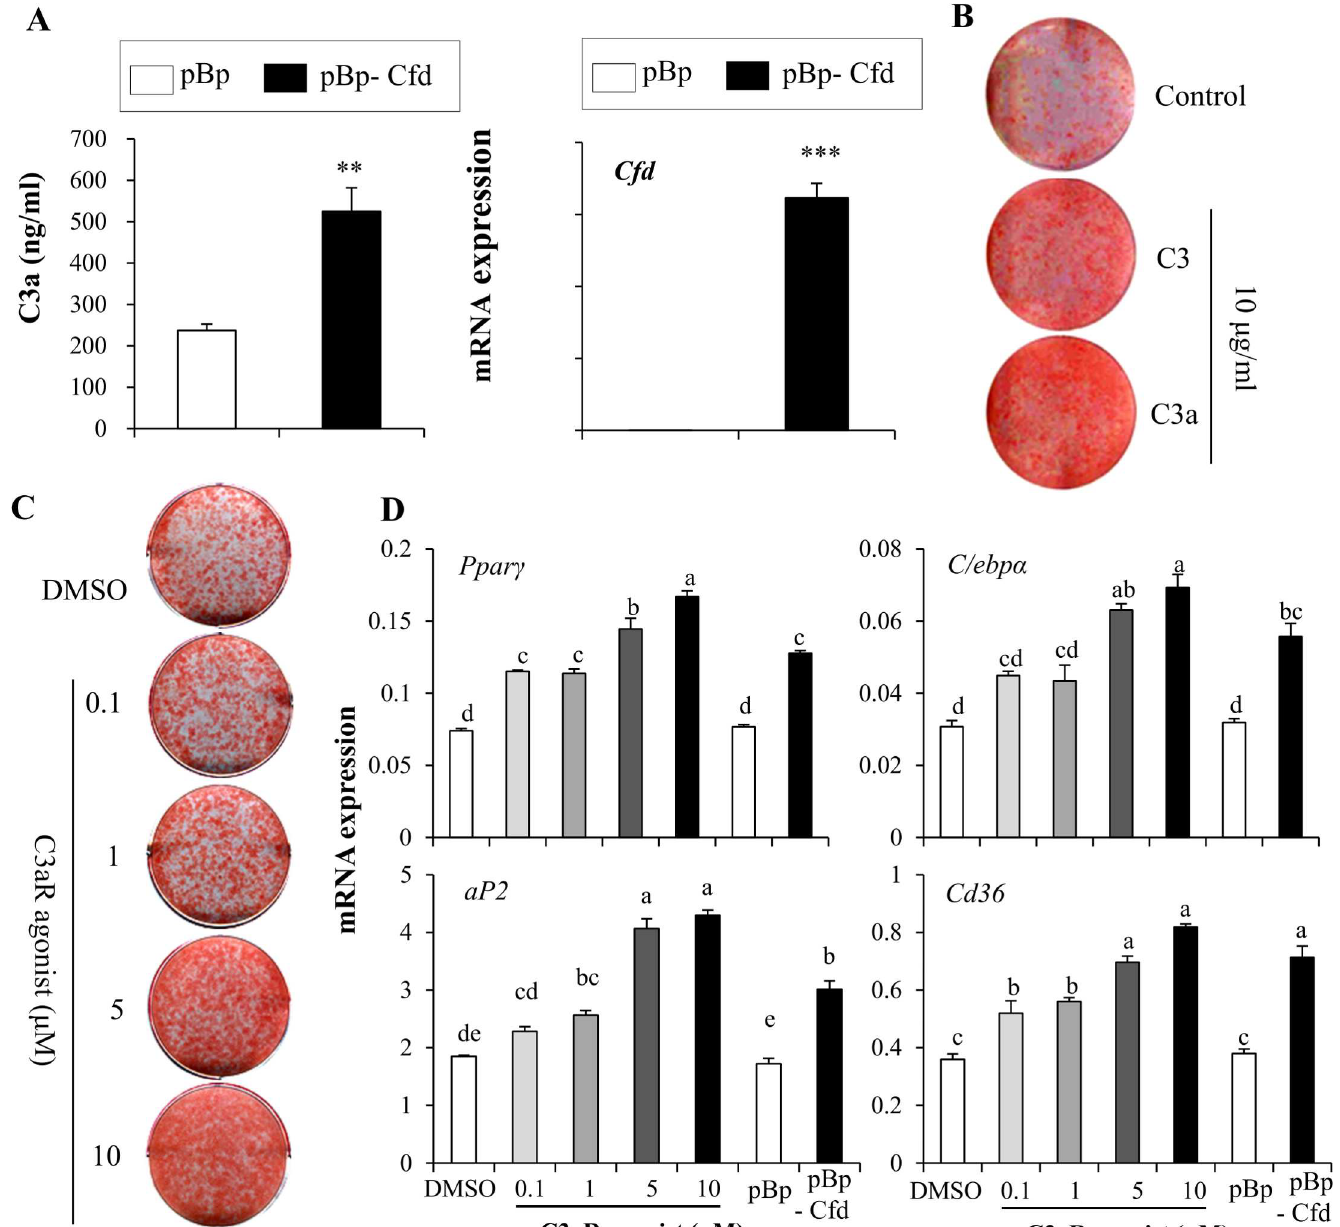
Fig 5. Cfd promotesadipocyte differentiationthroughC3a-C3aR activation. ( A ) IncreasedC3a productionwas observed in Cfd stably overexpressing 3T3-L1cells. Mediawas collectedfromcontrolor Cfd overexpressing cells and C3a contentwas measuredby ELISA as describedin methods.( B ) Treatment with C3 or C3a increasedlipid accumulation. ( C ) C4494,a known C3a agonist, stimulated lipid accumulationin a dose- dependent mannerin 3T3-L1 cells. ( D ) Expression of Ppar γ , C/ebp α , aP2 , and Cd36 was also increasedby C4494. 3T3-L1cells stably expressing pBabe-puro empty vector (pBp)or pBabe-Cfdgene harboringretrovirus(pBp-Cfd)were used as controls.Data are presentedas means +/- s.d. and are representative of threeindependent experiments. Statisticalsignificance differences were determined using one- way ANOVA and the Student-Newman- Keuls test. Different letterat each samplesare significant( P <